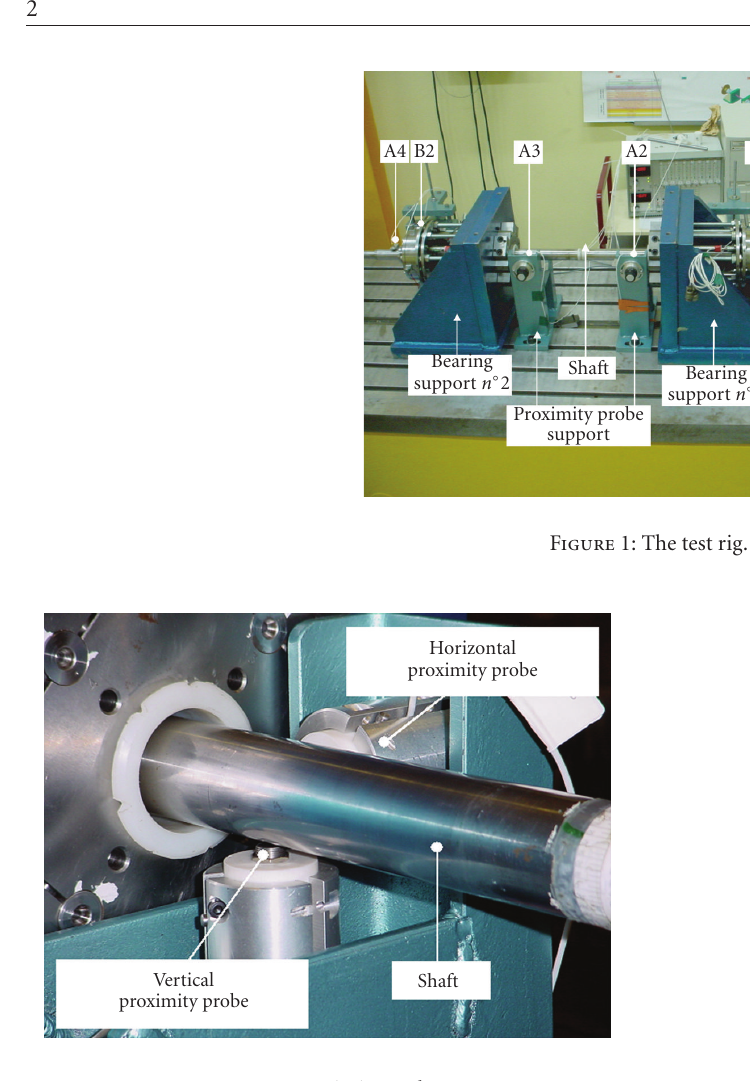
Figure 2: Proximity probes. Figure 3: Accelerometers and temperature